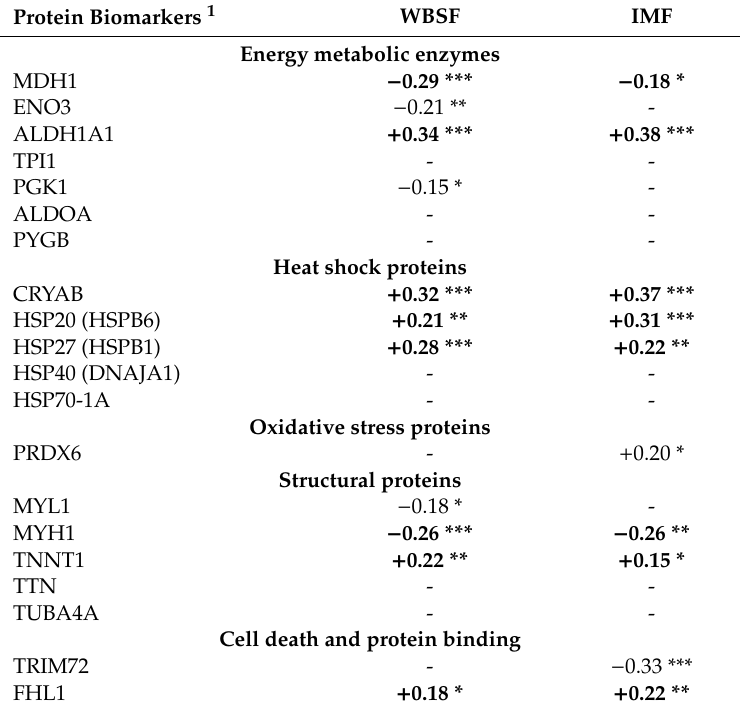
Table 2. Pearson correlation analyses between the 20 protein biomarkers with WBSF values and Intramuscular fat